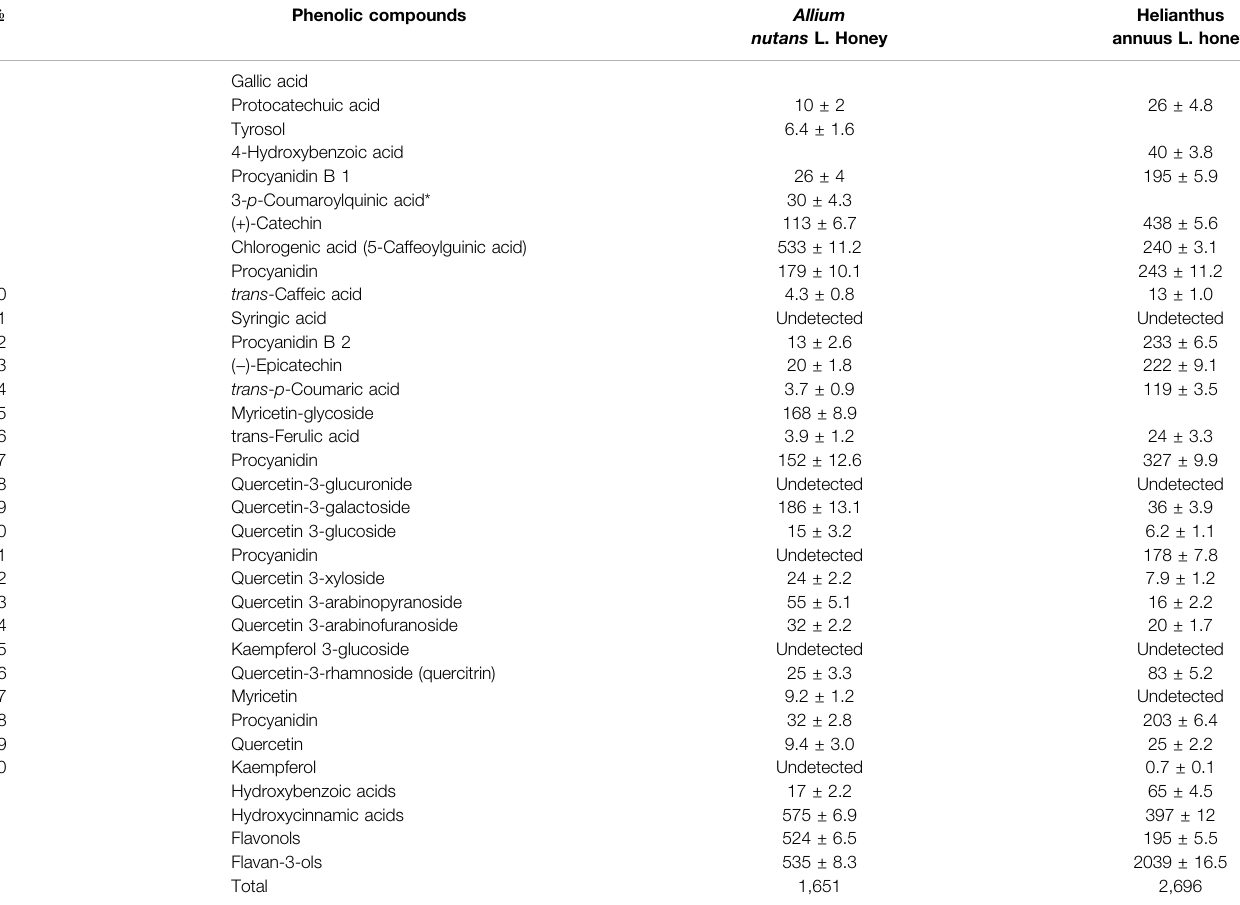
TABLE 1 | Phenolic compounds in ethyl acetate extract of the honey Allium nutans L. and Helianthus annuus L. honey (mg/kg). № Phenolic compounds Allium